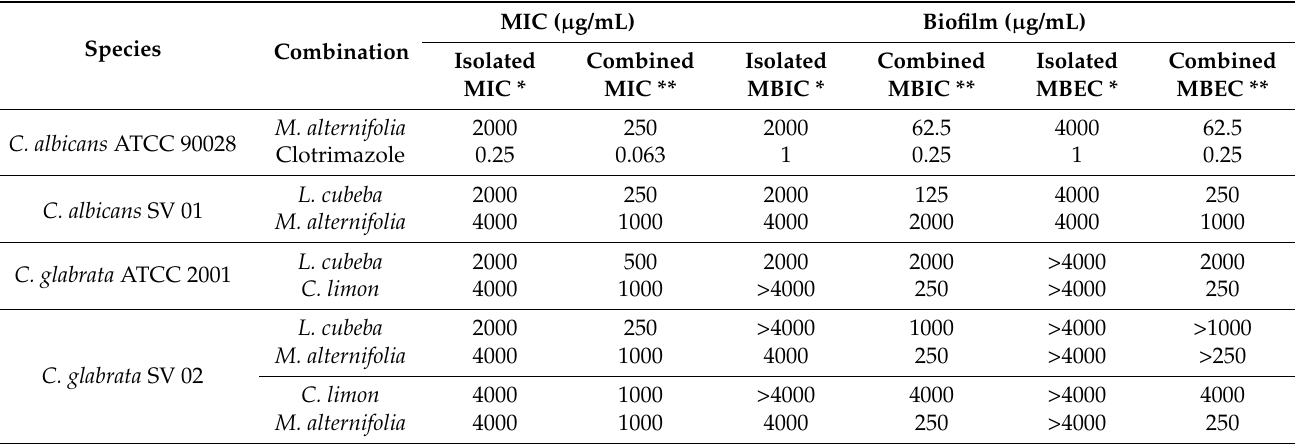
Table 4. Minimum inhibitory, biofilm-inhibitory and biofilm-eradication concentrations of EO–EO and EO–clotrimazole combinations against Candida